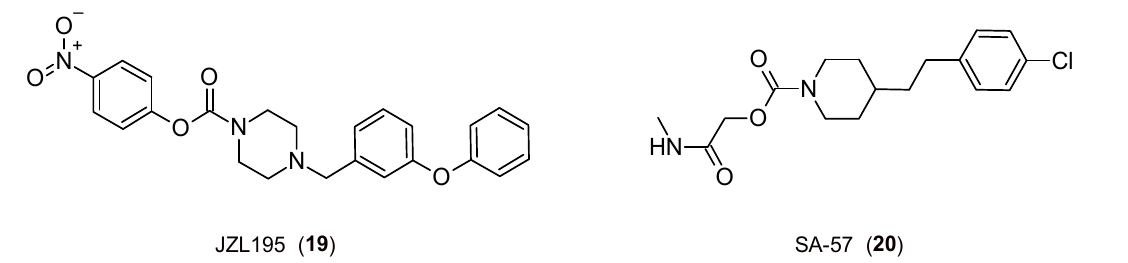
Figure 5. The 2D structures of the selected FAAH/MGL inhibitors.